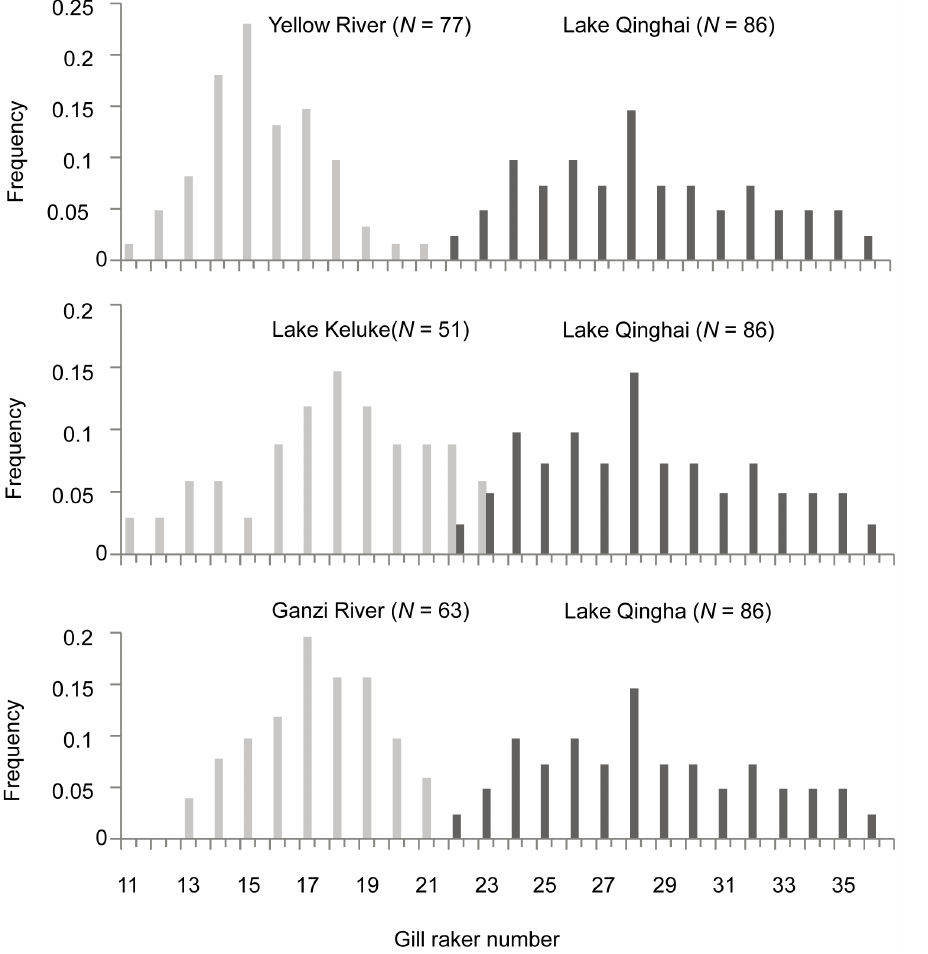
Figure 4. A comparison of the gill raker number distribution in Gymnocypris individuals from different bodies of water. The densely rakered morph in Lake Qinghai were compared to the sparsely rakered Yellow River G. e. eckloni , Ganzi River G. p. ganzihonensis and Lake Keluke G. p. przewalskii , respectively. Sample size ( N ) is given.